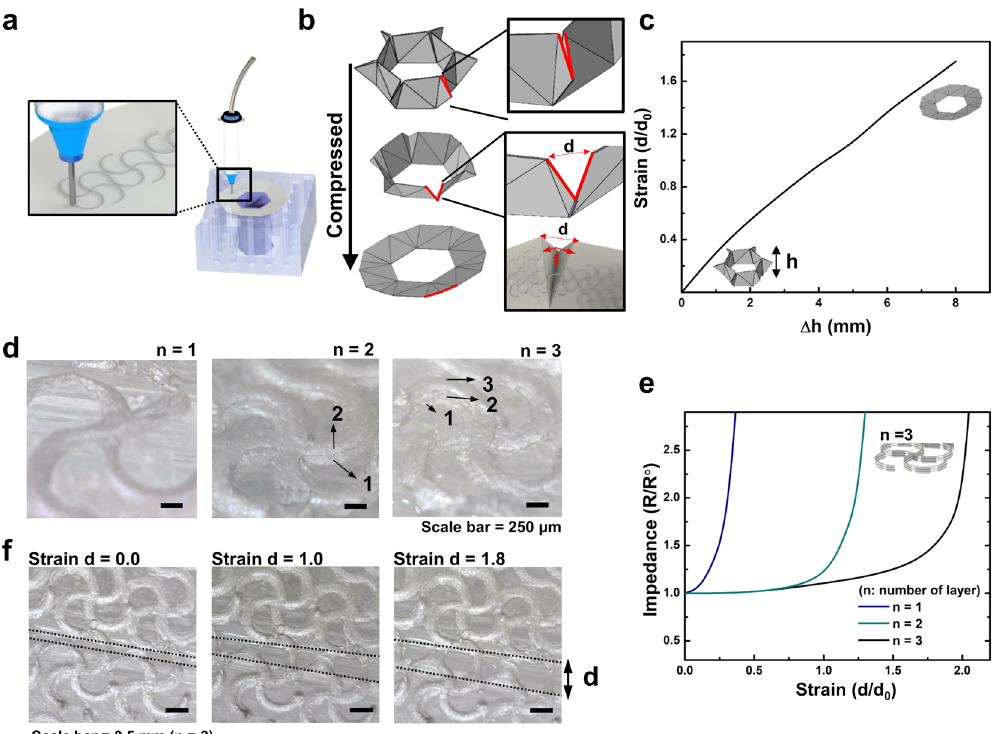
Fig. 4 3D printed dry electrocardiogram (ECG) Electrode with conductive serpentines. Schematics of a 3D printing process of serpentine electrodes on the non-auxetic origami surface, and b the folding and unfolding behaviors of non-auxetic origami. Gap distance, d , is wider once the origami is compressed. The direction of force, f , during the folding is highlighted with red arrows. c Relation of gap distance with height changes of z -direction. d Optical microscopic images of the 3D printed electrodes with the different layered number, n . e The different strain values from 0 to 1.8 with the sample of n = 1 ~ 3 ( R 0 = 3.46 × 10 − 1 Ω ). f The normalized impedance of the 3D printed serpentine electrodes with different printing